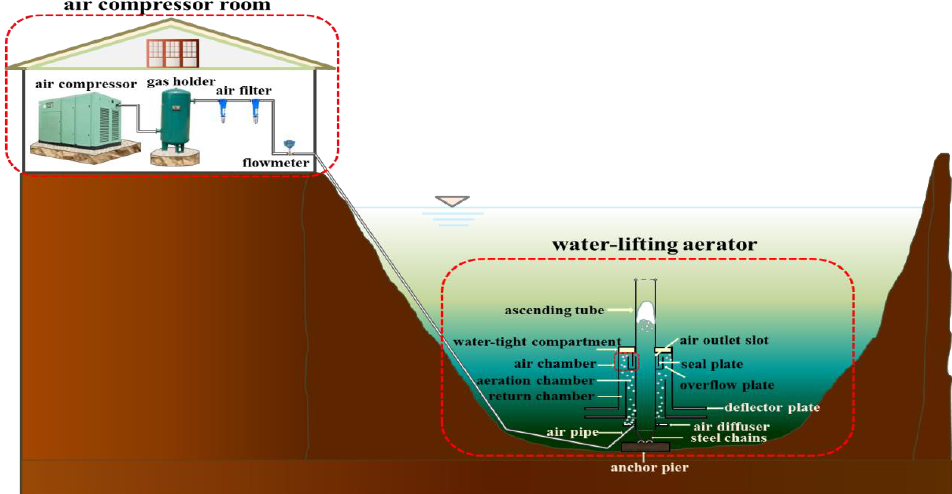
Figure 1. Water -lifting aerator (WLA) system